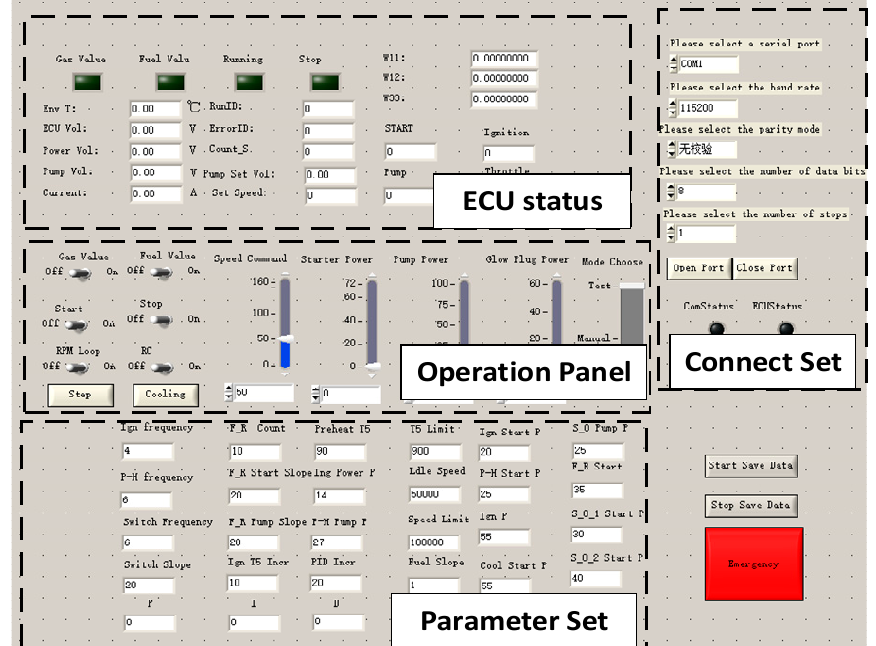
Figure 12. The user interface for experiments.